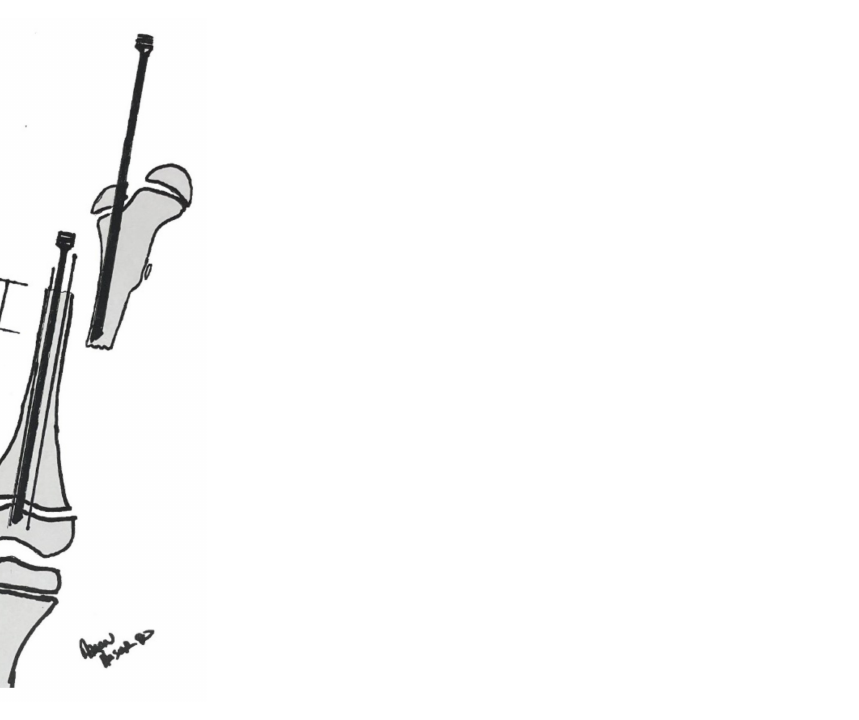
Figure 7. Drawing of the rod in the proximal femoral fragment and a rod in the distal femoral fragment crossing the distal physis. There are two 1.8 or 1.5mm wires also traversing the distal fragment and through the physis to prevent an iatrogenic fracture. Notice the distal fragment is allowed to migrate proximally to decrease tension on the neurovascular bundle; this distance is denoted as “N”. The knee will now be gently extended and the amount “N” will be the amount removed from the distal fragment for the shortening. Copyright Aaron Huser,